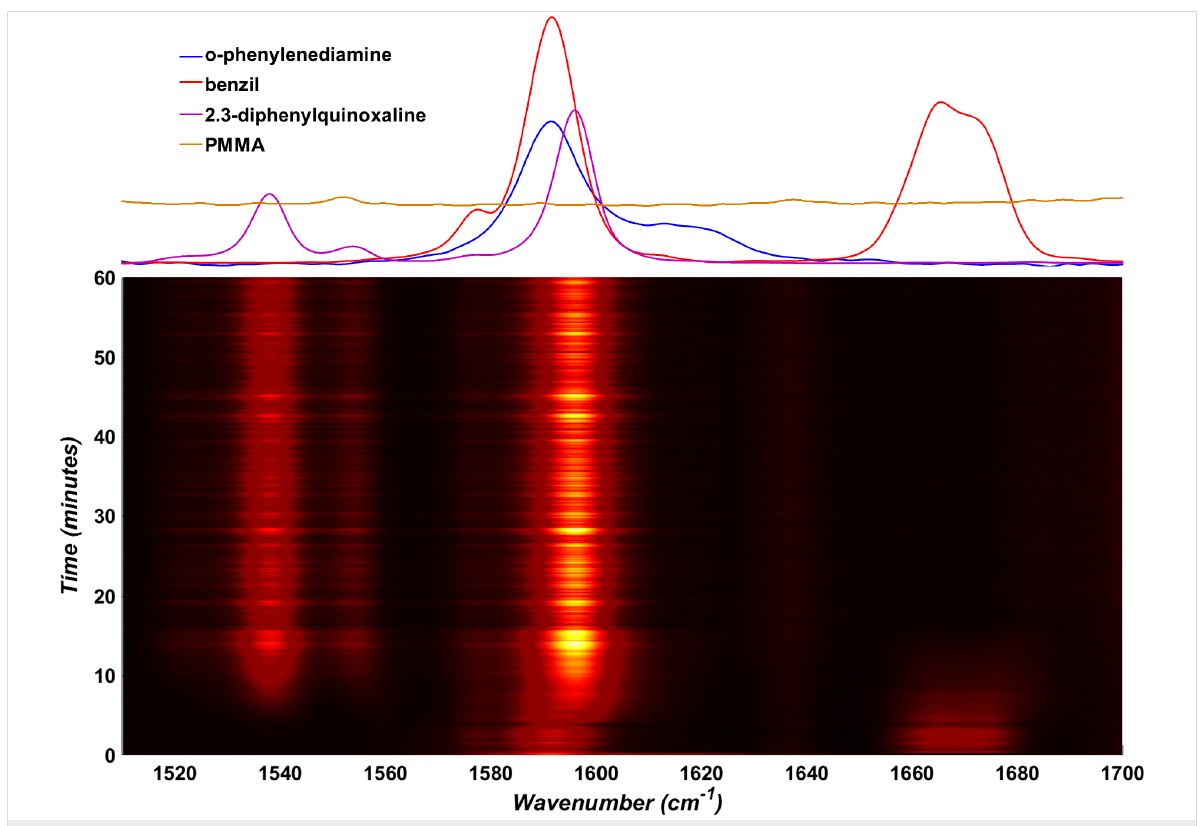
Figure 2: Section of the time-resolved Raman spectrum for the model mechanochemical reaction conducted at 30 Hz, that was selected for least- squares fitting. Normalized and baseline-corrected spectra for pure o- phenylenediamine (blue), benzil (red), 2,3-diphenylquinoxaline (purple) and an empty PMMA milling jar (yellow, offset for clarity) are shown above the time-resolved